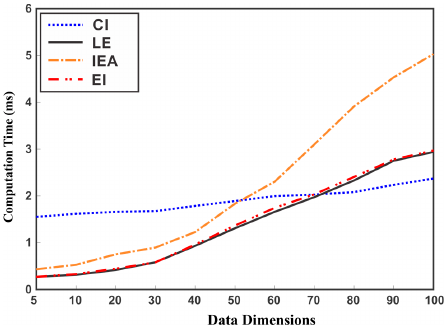
Figure 11. Comparison of CI and ME methods in terms of computation time for different dimensions of data.